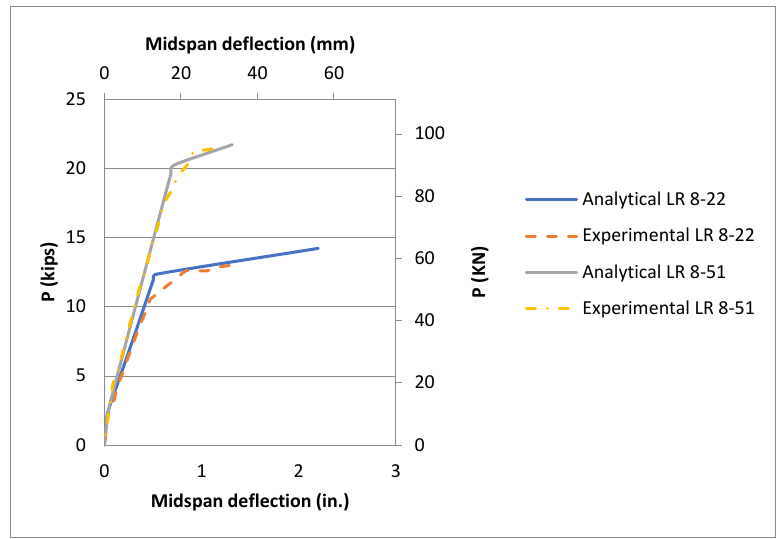
Figure 10. Arduini et al., (1997) [14], Tavares et al., (2008) [13] and Spadea et al., (1998) [15] mo- ment vs. maximum compressive strain analytical graphs.